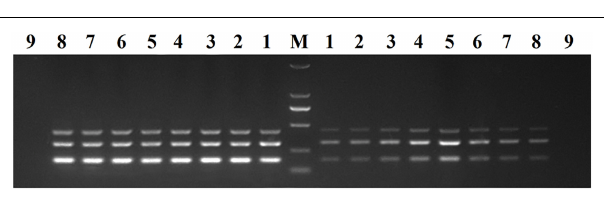
FIGURE 2 | Optimization of the annealing temperature. The results of DPO-nanoPCR were on the left and the results of conventional PCR were on the right. Lane M, DL2000 DNA marker; Lane 1–8, 41.7 ◦ C, 45.6 ◦ C, 48.8 ◦ C, 52.6 ◦ C, 56.2 ◦ C, 60.9 ◦ C, 63.4 ◦ C, and 64.1 ◦ C; Lane 9, negative